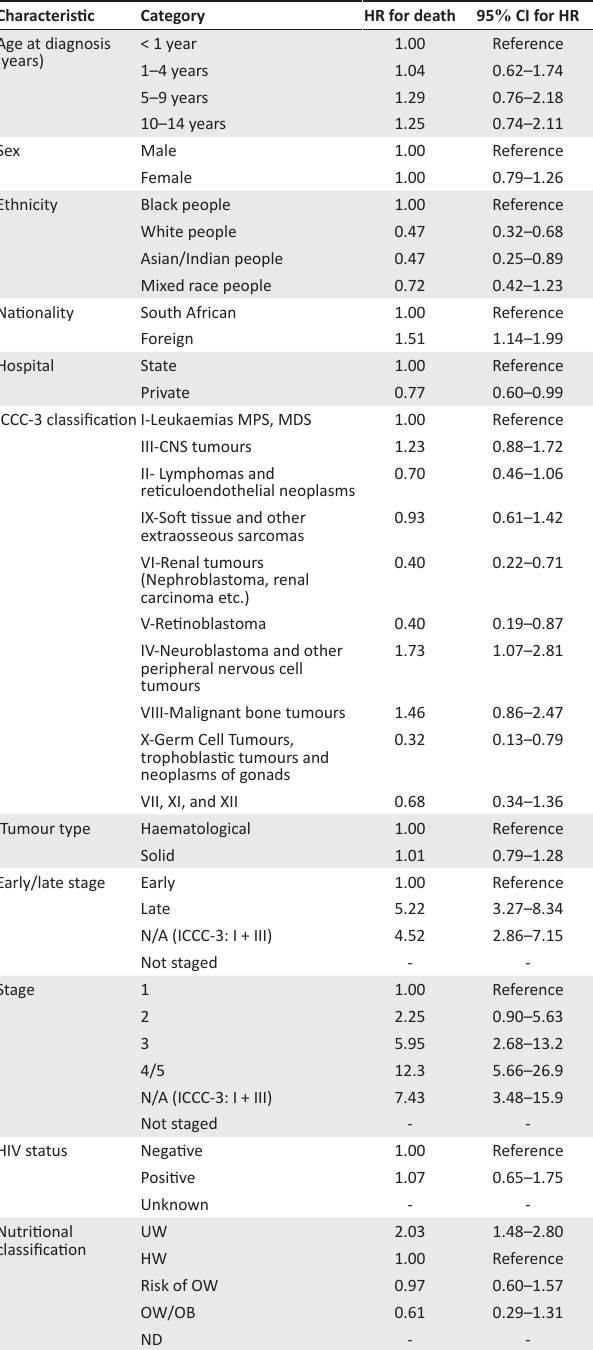
TABLE 3: Multivariable analysis: Childhood cancer determinants of overall survival ( n =